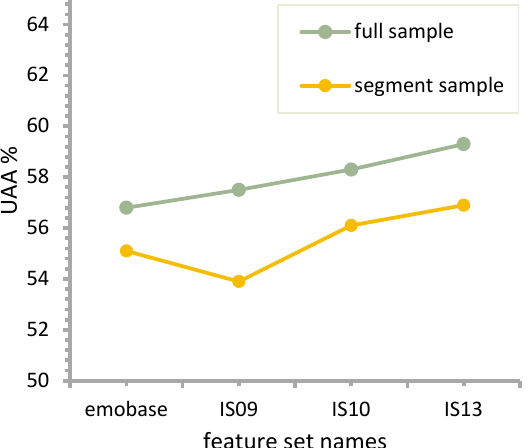
Figure 6. Comparison of four global feature set classification results.